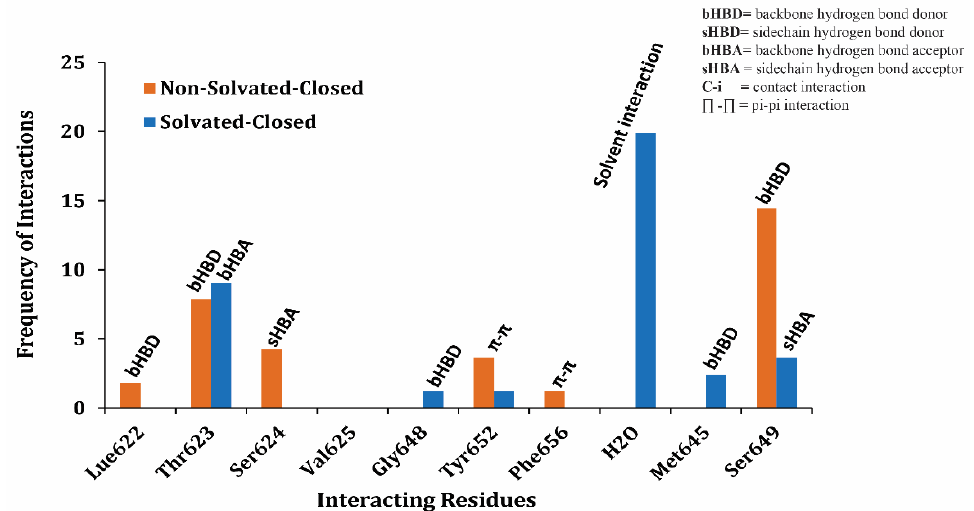
Figure 8. The population histogram summarizes the frequency of occurrence of interactions of ligand–protein interaction profiling between training dataset and non-solvated-closed (orange) and solvated-closed (blue) binding cavity.